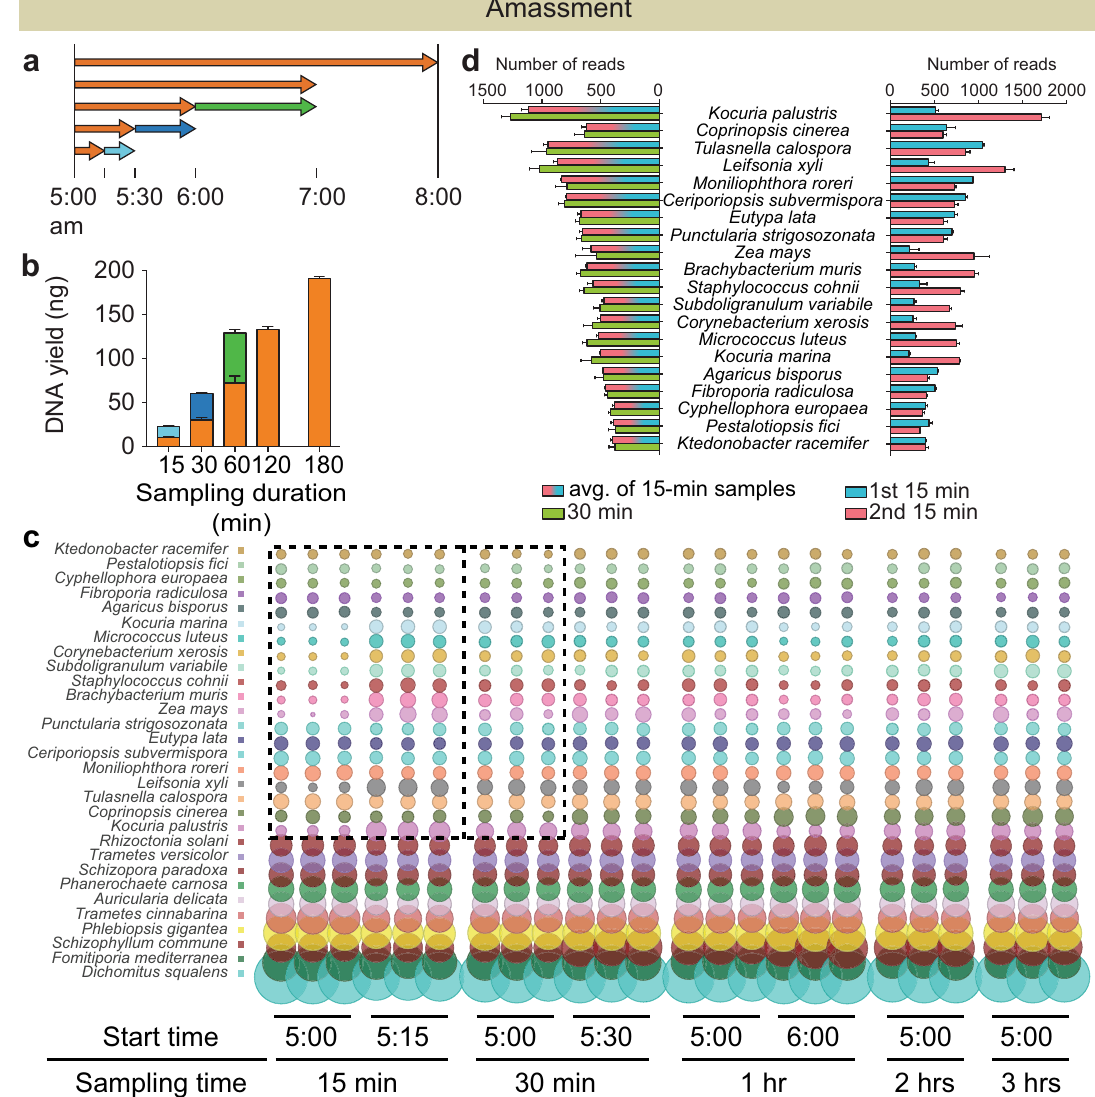
Fig. 3 Sampling duration assessment. a Illustration of different time-based sampling regimes. b Comparison of DNA yield (ng) between the corresponding sampling regimes, e.g. fi rst 15-min yield (orange) + second 15-min yield (light blue) compared to fi rst 30-min yield (orange). The bars represent mean values and the error bars were standard deviation among the replicates. c Taxonomic compositions of the top 30 species, the highlighted portion focuses on species which shifted in abundance between the fi rst and second 15-min samples. d Comparison of relative abundances of the selected species, the fi rst and second 15-min samples were averaged and compared to the taxonomic composition of fi rst 30-min sample. The bars represent mean values and the error bars were standard deviation among the